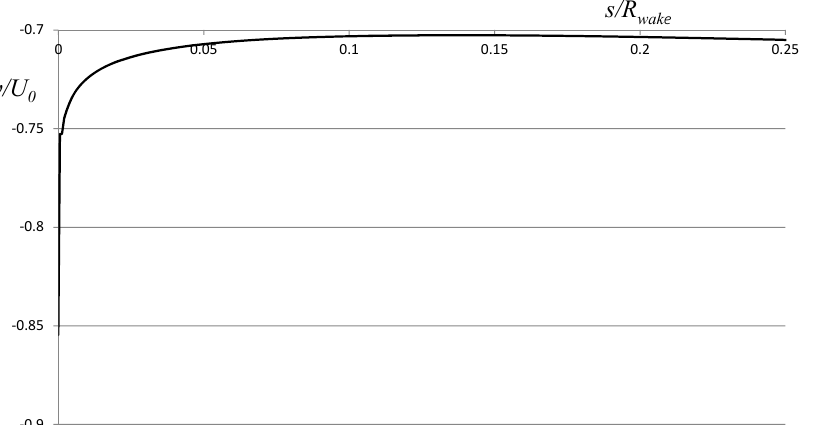
Figure 4. The velocity components at x = 0 for (cid:49)H/ ( 1 displays r/R .